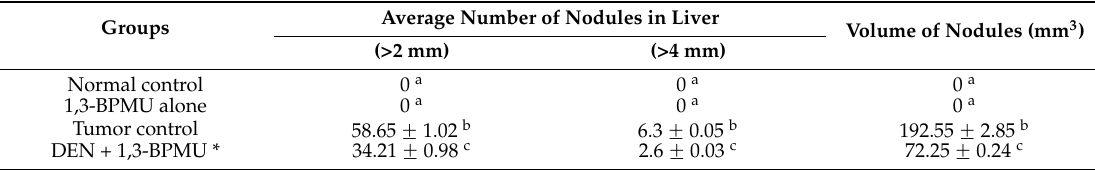
Table 2. Effect of 1,3-BPMU on hepatocarcinoma